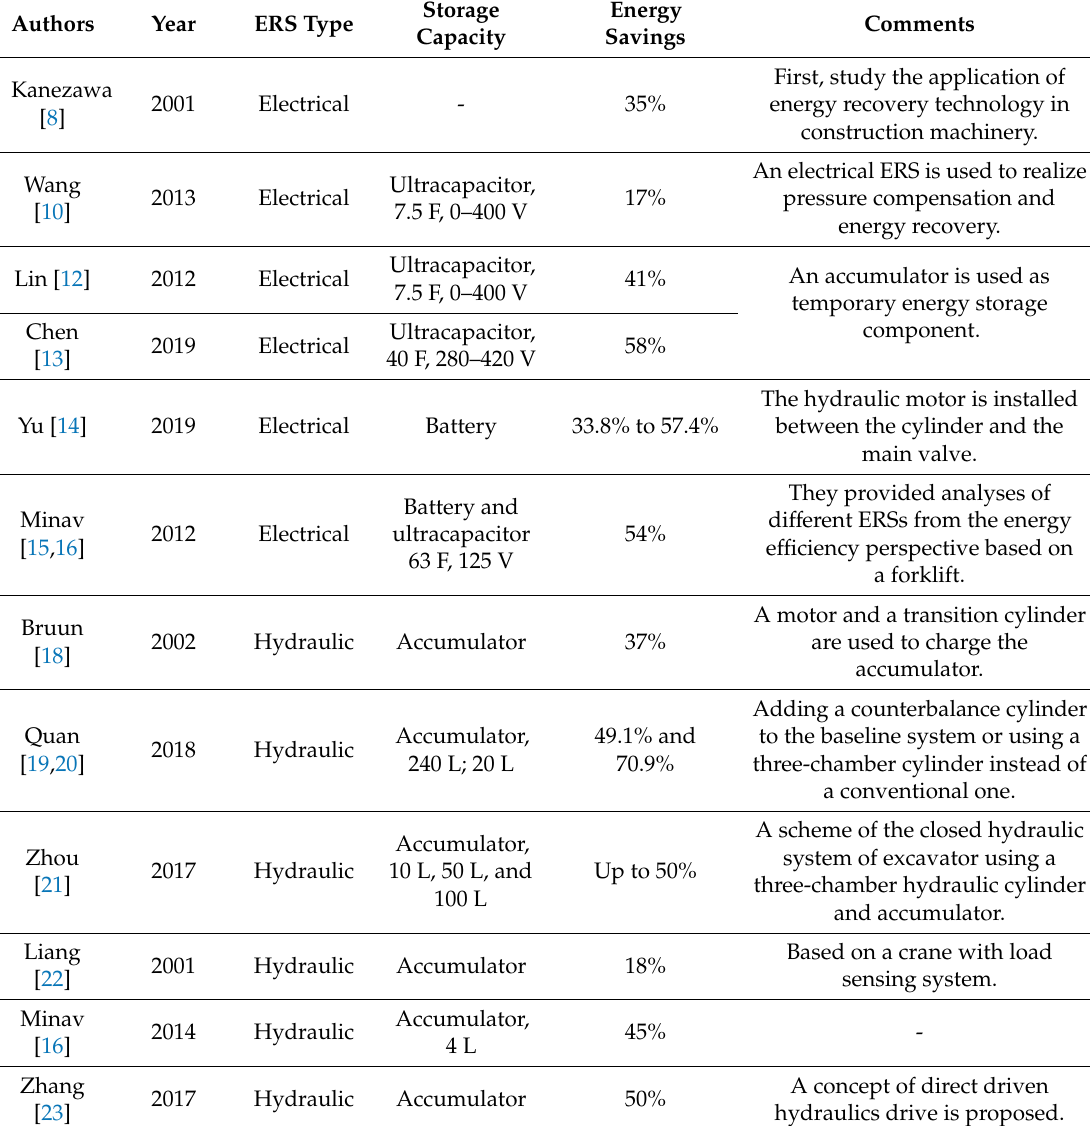
Table 1. The outline of typical construction machinery with di ff erent types of energy recovery